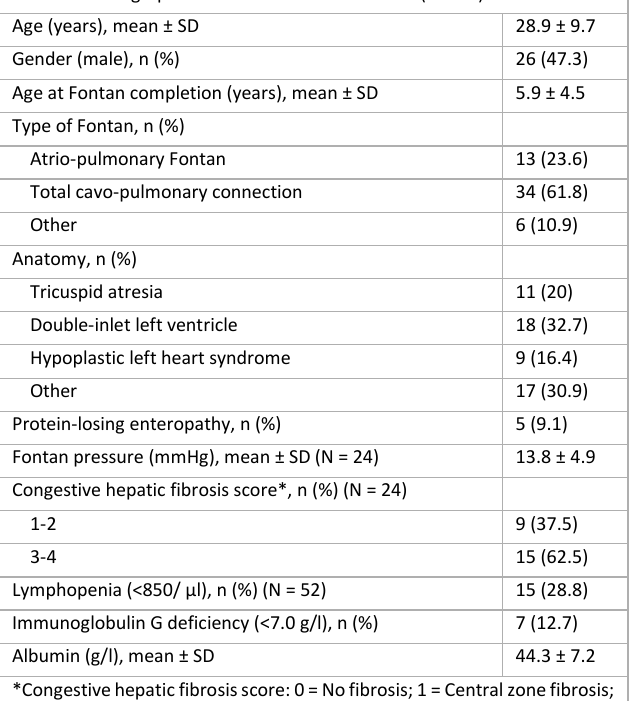
Table 1: Demographics and clinical characteristics (N = 55) Age (years), mean ± SD 28.9 ± 9.7 Gender (male), n (%)